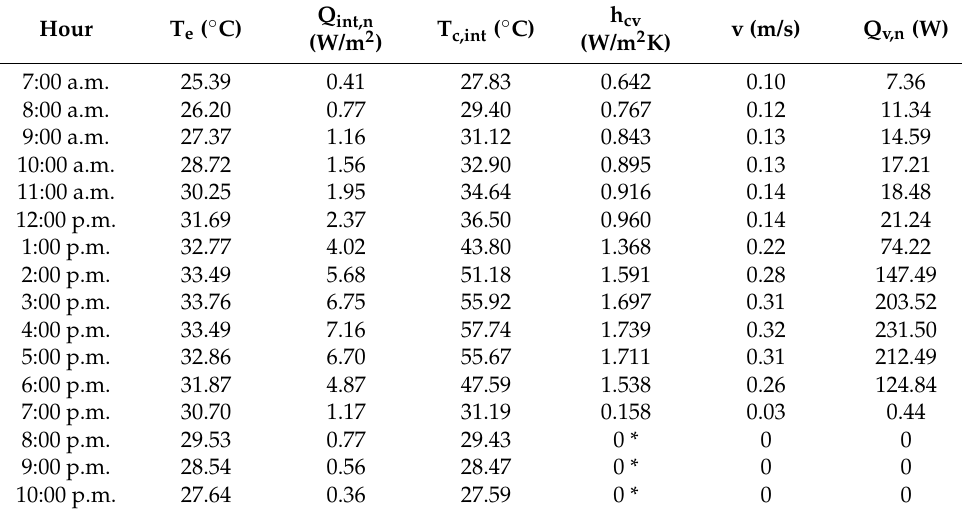
Table 6. Hourly values of the heat flux through the façade (Q int,n ), temperature of the internal cavity face (T c,int ), convective coefficient inside the cavity (h cv ), air velocity inside the cavity (v), and heat flux removed from the cavity (Q v,n